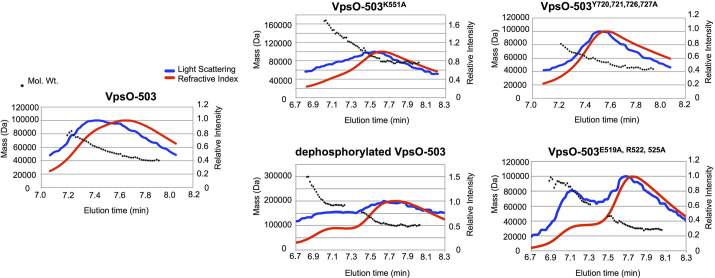
Tyrosine phosphorylation affects VpsO oligomerization.Multi-angle light scattering data for the indicated purified VpsO-503 kinase domain proteins. The peak(s) for each protein eluted from a size-exclusion chromatography column is shown with the relative intensity of light scattering (blue, right y-axis), refractometer signal (red, right y-axis), and the calculated molecular weight (black circles, left y-axis). Proteins were loaded at 1.5 mg/mL. A second peak, corresponding to a higher molecular weight species, could be detected in some experiments and likely reflects a concentration-dependent oligomerization equilibrium.